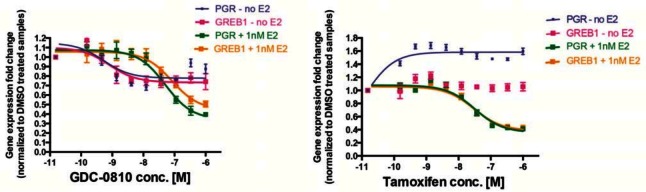
MCF7 cells were treated with increasing concentrations of either GDC-0810 (left) or 4OH-tamoxifen (right), for 6 hours, prior to analysis of PGR and GREB1 as ER target genes, by Taqman assays.Gene expression was normalized to DMSO control (set to 1) either in the presence or absence of 1nM E2.